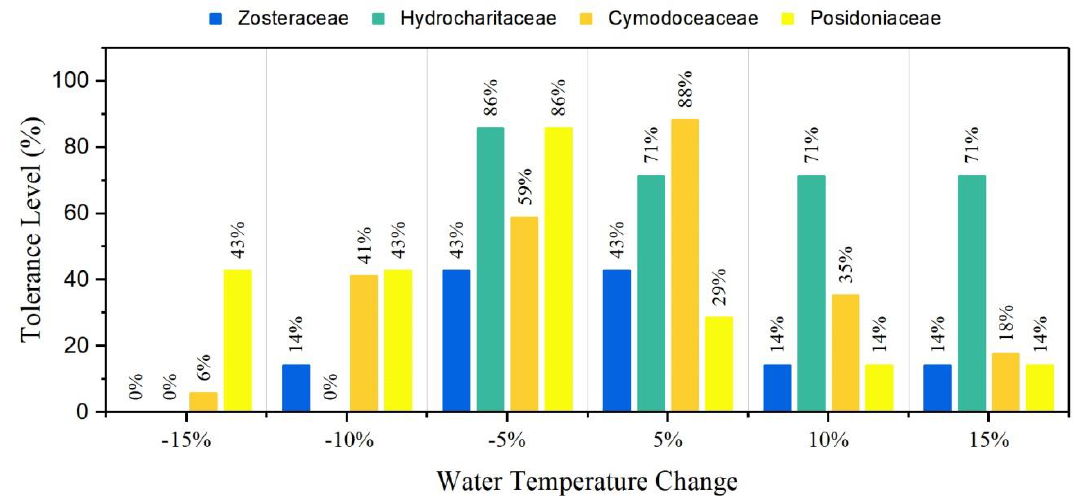
Figure 10. Seagrass tolerance by family on water temperature change from initial values. Bars represent the percentage of locations/meadows that remain unchanged under different water temperature scenarios.